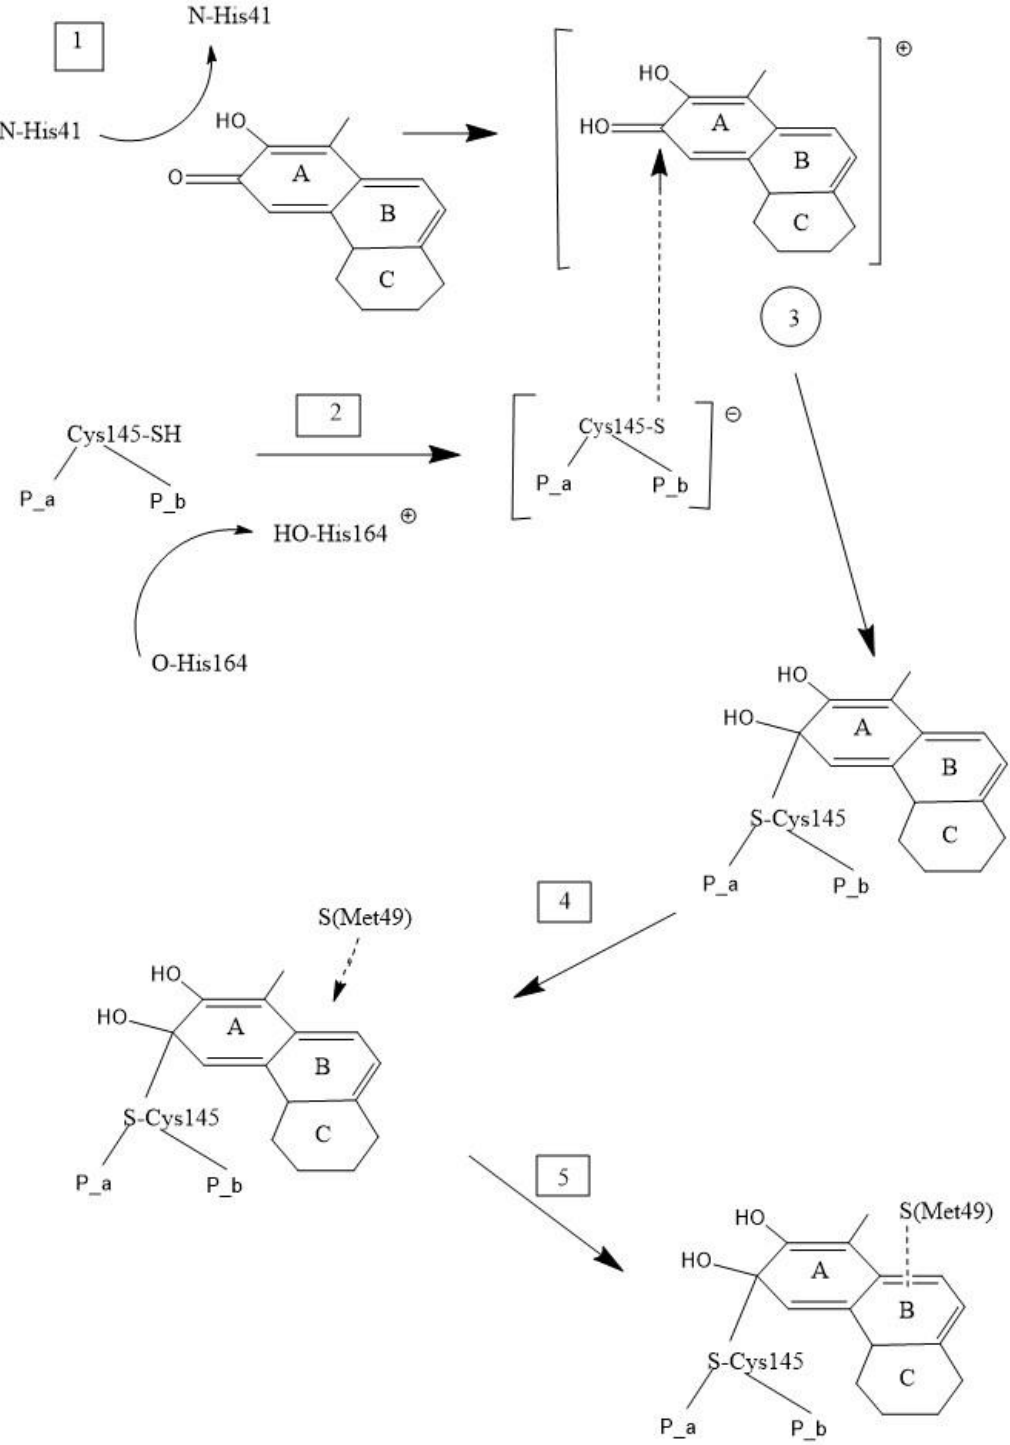
Scheme 2. Mechanism of main COVID-19 protease inhibition by celastrol. P_a and P_b represent the